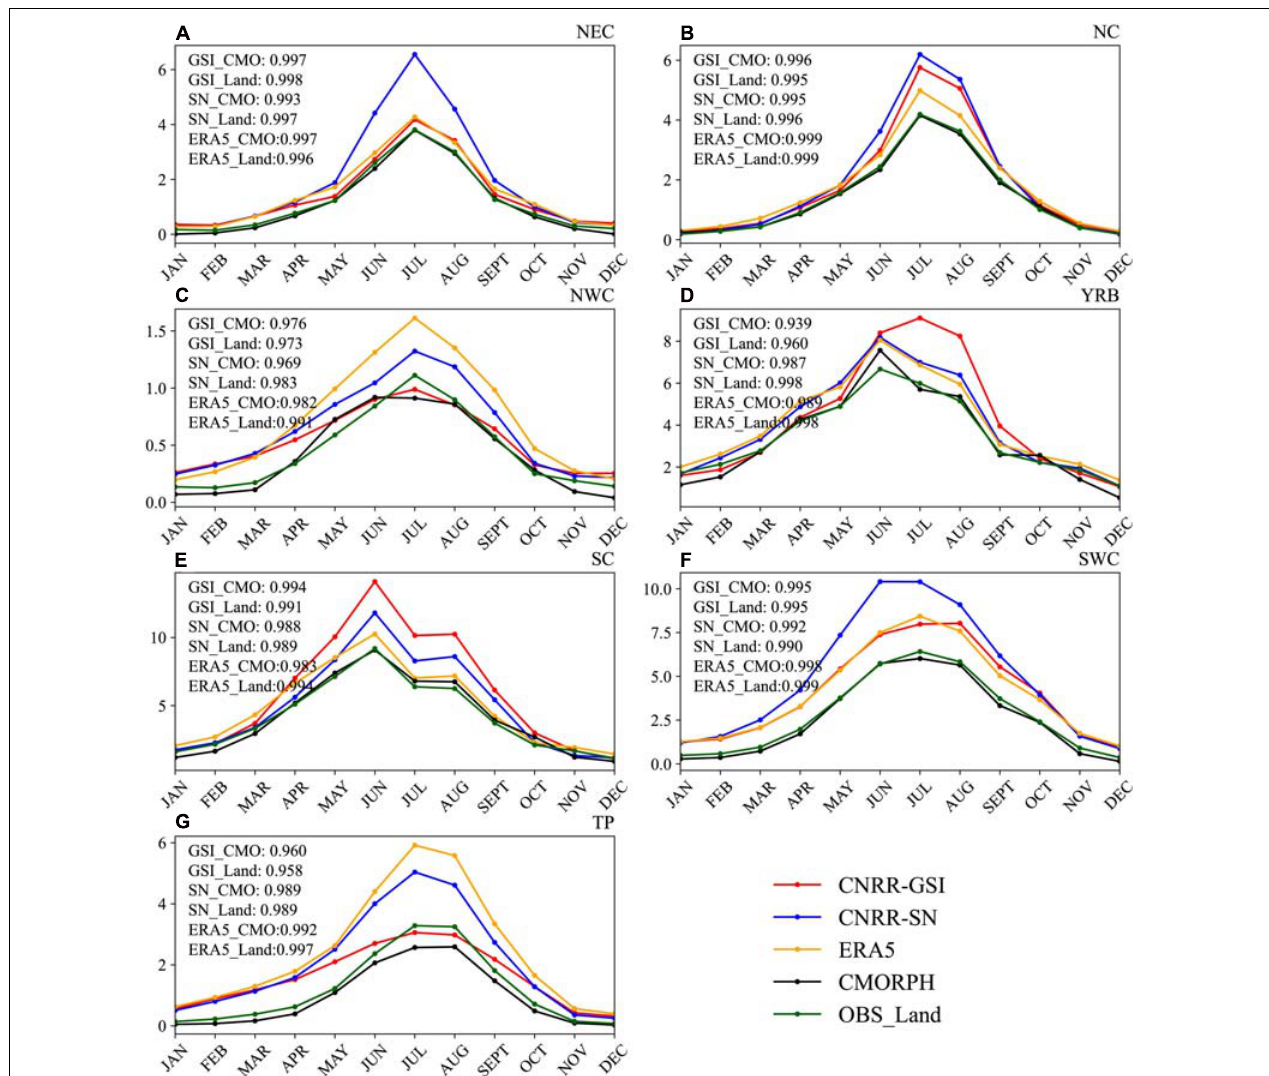
FIGURE 3 | Monthly precipitation produced by the CNRRs, observations and ERA5 over 7 sub-domains over China. The correlation coefficients are calculated for the different sub-domains. GSI_CMO, SN_CMO and ERA5_CMO stand for the correlation between CNRRs and CMORPH. GSI_Land, SN_Land and ERA5_Land stand for the correlation between CNRRs and